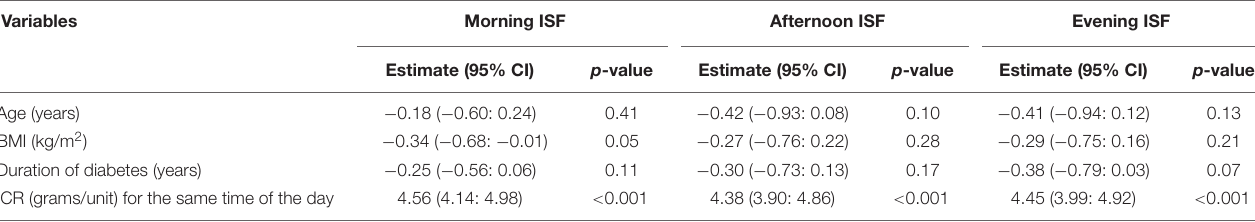
TABLE 6 | Multiple regression analyses for factors associated with insulin sensitivity factors at different times of the day. Variables Morning